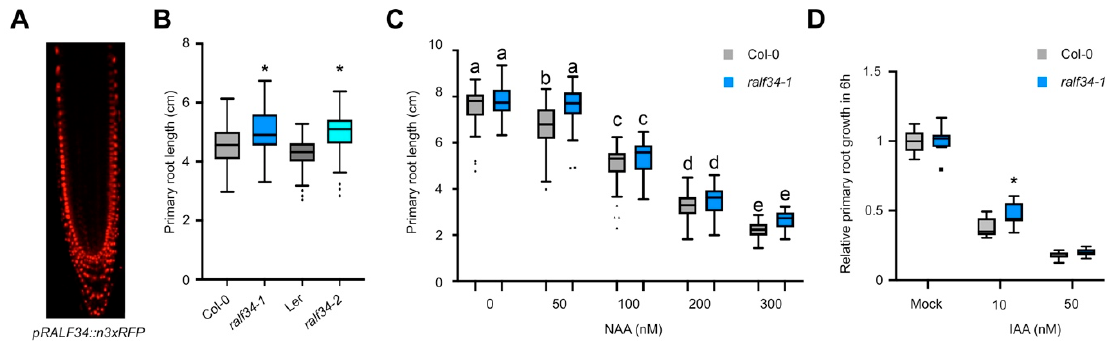
Figure 5. RALF34 impacts auxin-controlled primary root growth. ( A ) RALF34 expression in the primary root tip as visualised through pRALF34::n3xRFP in 7-day-old seedlings. ( B ) Primary root length (cm) of 7 days after germination seedlings: wild type Col-0 (n = 133), L er (n=40), and RALF34 T-DNA insertion mutants ralf34-1 (n = 104) and ralf34-2 (n = 120). Boxplots with Tukey-based whiskers and outliers (dots) show data from three biological replicates. Asterisks indicate statistical significance ( p < 0.001) based on Student’s t-test when T-DNA line is compared to its control. ( C ) Primary root length (cm) of Col-0 and ralf34-1 seedlings 10 days after germination grown on various concentrations of NAA: 0 nM/EtOH mock (n = 63 and 48 for Col-0 and ralf34-1 , respectively), 50 nM (n = 59 and 56 for Col-0 and ralf34-1 , respectively), 100 nM (n = 61 and 41 for Col-0 and ralf34-1 , respectively), 200 nM (n = 62 and 43 for Col-0 and ralf34-1 , respectively) and 300 nM (n = 41 and 24 for Col-0 and ralf34-1 , respectively). Boxplots with Tukey-based whiskers and outliers (dots) show data from 2 biological replicates. Letters indicate significant difference according to two-way ANOVA with Tukey post-hoc test ( p < 0.05). ( D ) Normalised growth for 6 h (to mock condition) for 5-day-old Col-0 and ralf34-1 seedlings treated with indicated IAA concentration. Boxplots with Tukey-based whiskers and outliers (7 < n < 11). Asterisks indicate statistical significance ( p < 0.05) based on Student’s t-test when ralf34-1 is compared to Col-0.